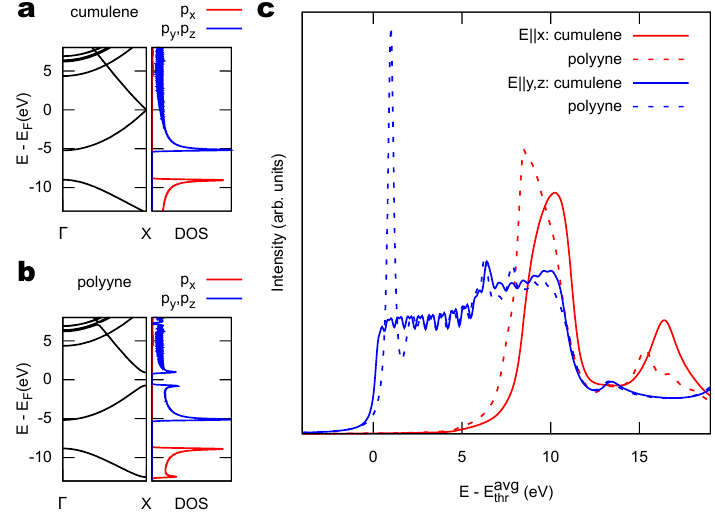
Figure 1. ( a , b ) Band structure (left) and corresponding density of states (right) for infinite 1D carbon chains of the cumulene family (=C=C=, BLA=0) and polyyne one (-C ≡ C-, BLA = 0.172 Å) [54], respectively. The DOS is projected over C 2p atomic orbitals, with x along the chain axis and y , z orthogonal to it. ( c ) Simulated near-edge X-ray absorption fine structure (NEXAFS) spectrum for different photon polarizations. Energies are reported with reference to the average C 1s ionization potential E avg . The wiggles that are especially evident at low energy are an artifact induced by the use thr of periodically repeated unit cells (here one C atom every 40 is